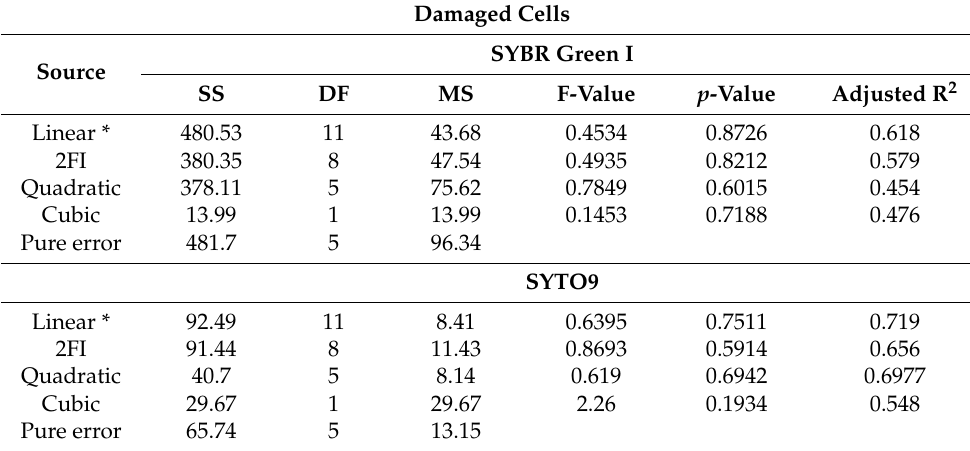
Table 3. Summarized statistics for model fit and results of lack-of-fit